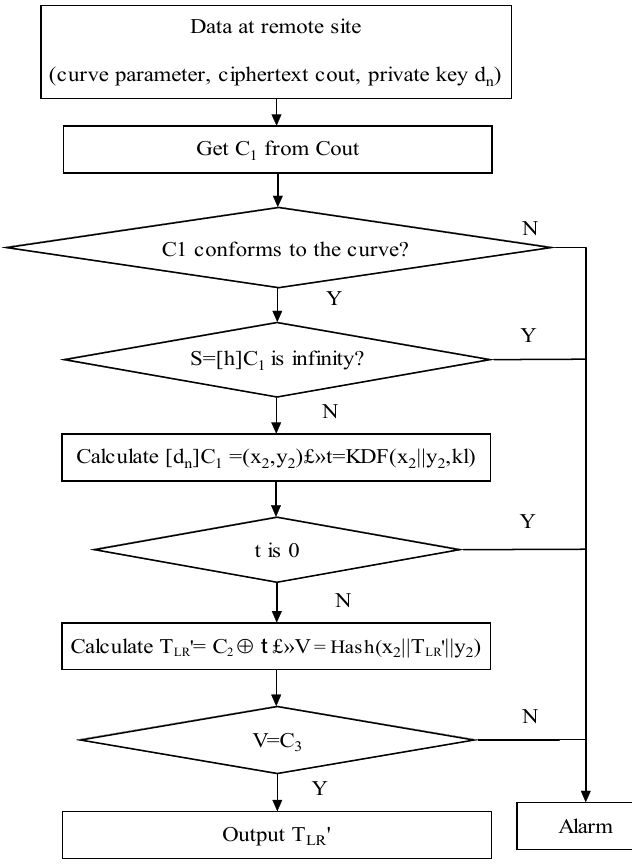
Figure 3. SM2 decryption algorithm.